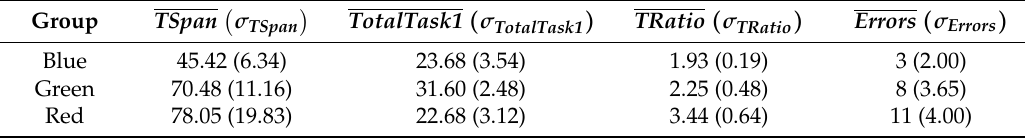
Table 2. Comparison of the level of dexterity found in each group. Each column represents the average and standard deviations for each variable in each group. The blue group has high dexterity, as they, in general, take shorter times, lower T Ratio values and made fewer errors. Conversely, the red group has lower dexterity, as they in general, take longer times, higher T Ratio values and made many errors. The green group has average dexterity.